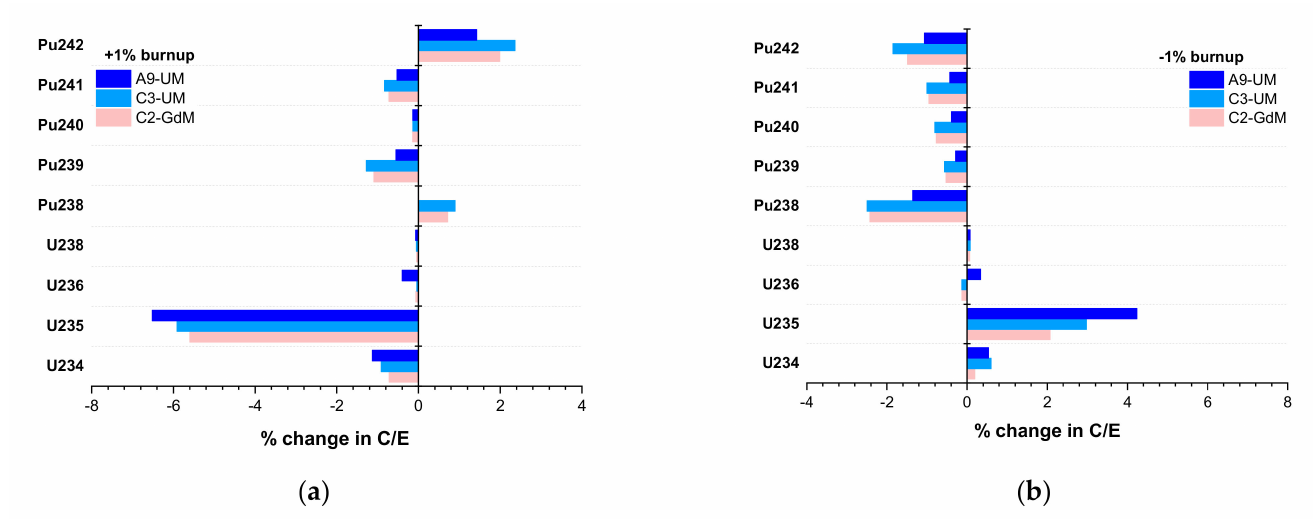
Figure 12. Change in U and Pu isotope C/E ratios due to change in sample burnup for samples from assembly 2F1ZN3: ( a ) 1% increase in sample burnup; ( b ) 1% reduction in sample